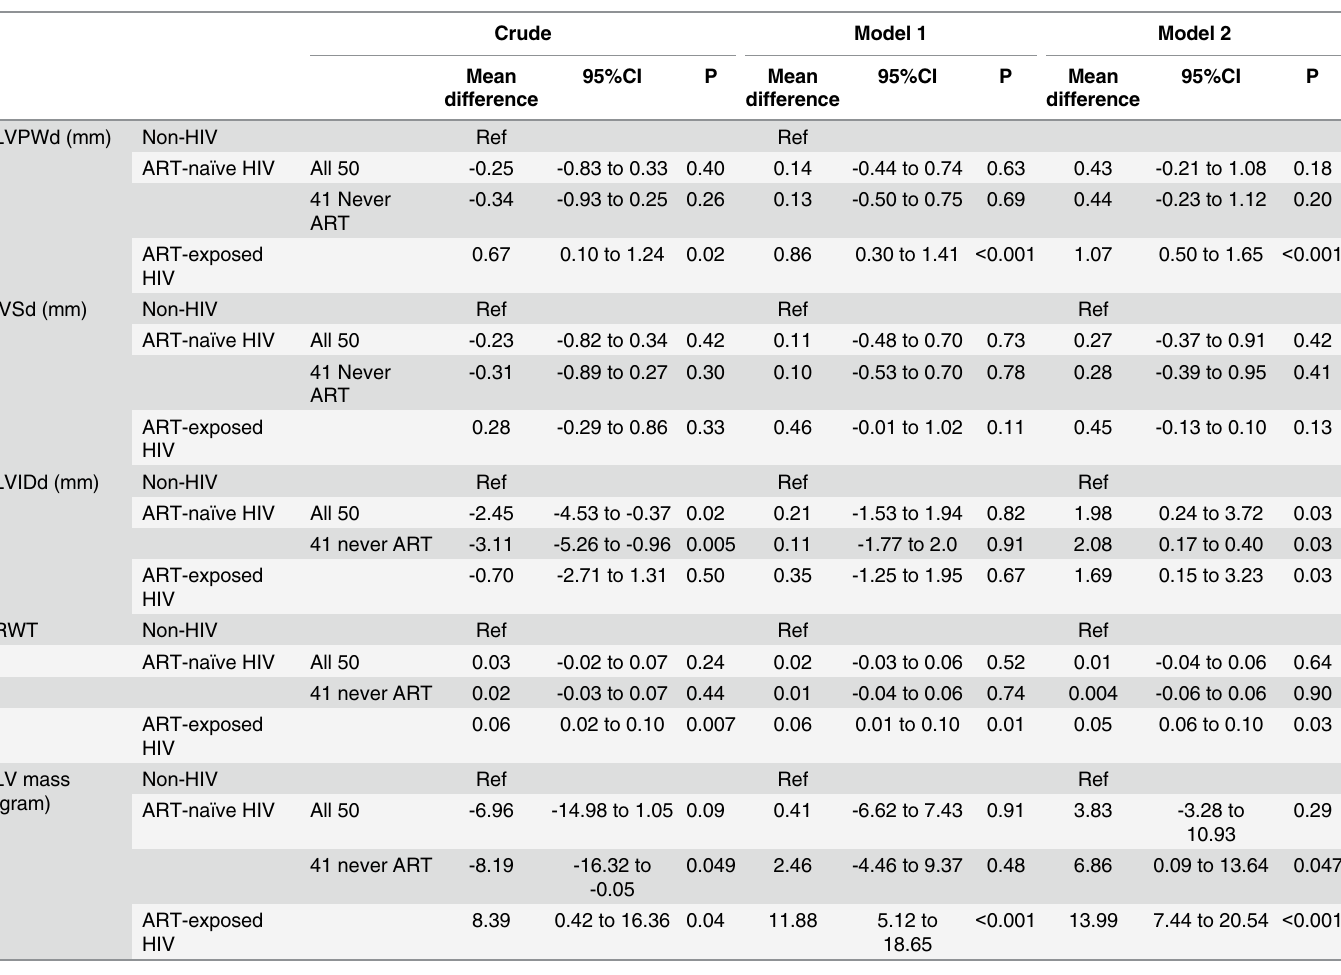
Table 2. Effects of HIV infection on cardiac structures.